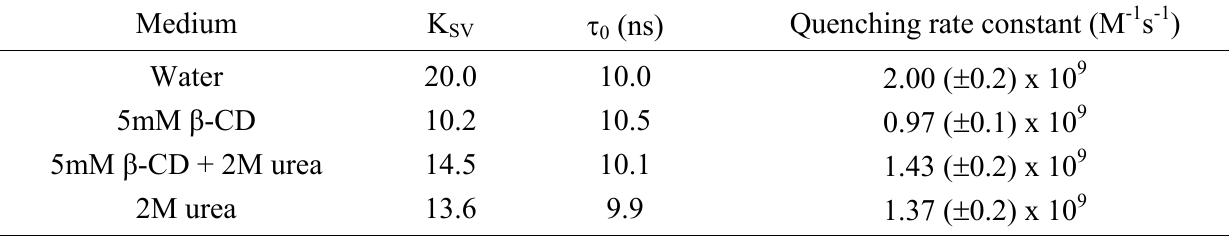
Table 8. Rate constants for quenching of CAZL by